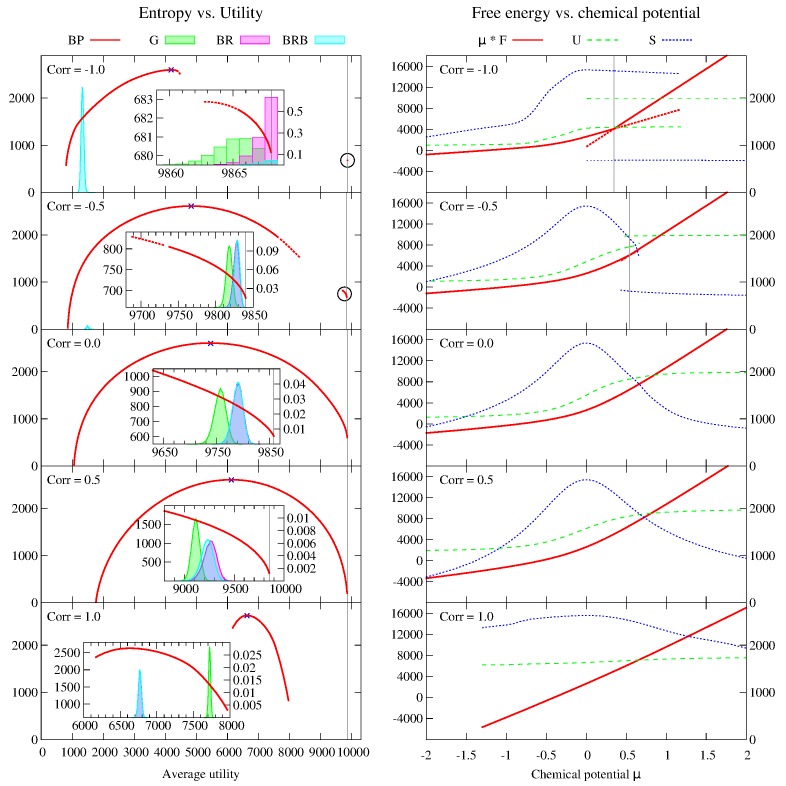
Computation of the average utility U and of the entropy S as a function of the parameter μ for single instances with correlation c equal to −1, −0.5, 0, 0.5 and 1 (from top to bottom).The other parameters are N = 1 000, M = 100, C = 120, q = 0.2, w
min = 6, w
max = 15, v
min = 1 and v
max = 10. The values of U and S vs. μ are shown on the right-hand column of plots, together with the Bethe free energy μF = μU + S. The values of U and μF are read on the left-hand scale, the values of S on the right-hand one. For c ≤ −0.5 a first order transition, corresponding to a discontinuity in the first derivative of the free energy, is clearly visible. The critical value μ* is marked by a vertical grey line, and the thermodynamically unstable branches of the free energy are dotted. The entropy is plotted as a function of the average utility on the left-hand column of plots. For c ≤ −0.5 the entropy curve has two branches, separated by a wide gap (the high utility branches, which cover a small interval of utilities, are shown in detail in the insets, and they are highlighted by a black circle in the main plots). Dotted lines correspond to the thermodynamically unstable branches of the free energy. For c ≥ 0 the entropy curve is uninterrupted. The blue crosses at the top of each curve represent the values obtained with μ = 0, i.e. the uniform average over all Nash equilibria, and they always coincide with the maximum of the entropy. The histograms represent the distribution of the total utilities found by the dynamics G, BR and BRB. The number of runs for each dynamics is always 105, except for BRB with c = −1 where it is 106. The frequency of each value of utility can be read on the right-hand scale of the insets. The gray vertical lines are upper bounds to the total utility defined as U
+ = ∑u maxa ∈ ∂u
v
ua.